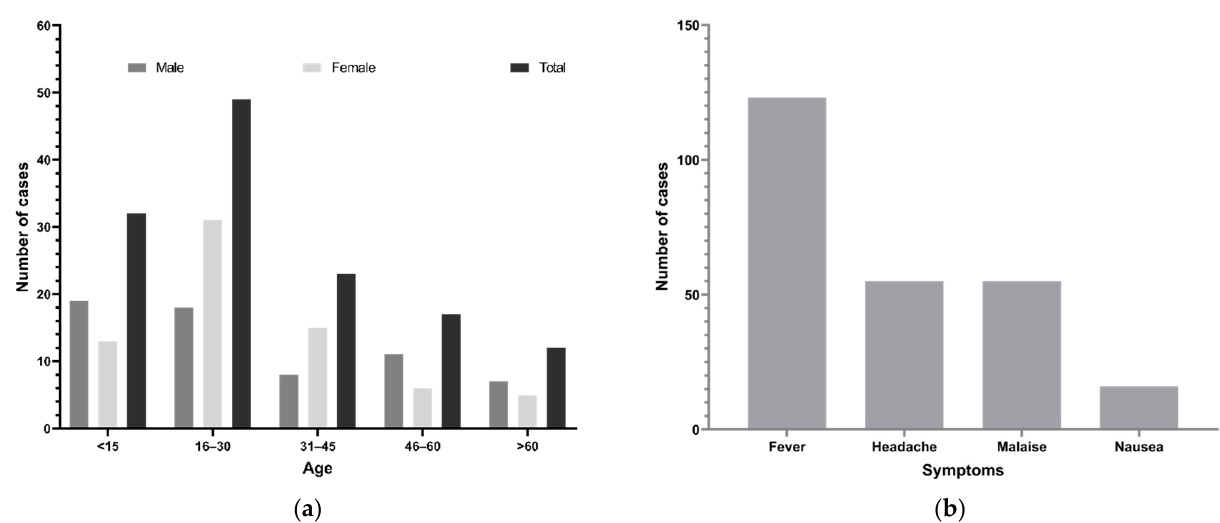
Figure 2. Demographics (age, sex) and clinical features of dengue suspected patients during the 2017 outbreak, Nepal. ( a ) Number of dengue suspected cases by age and sex groups. ( b ) Common symptoms.